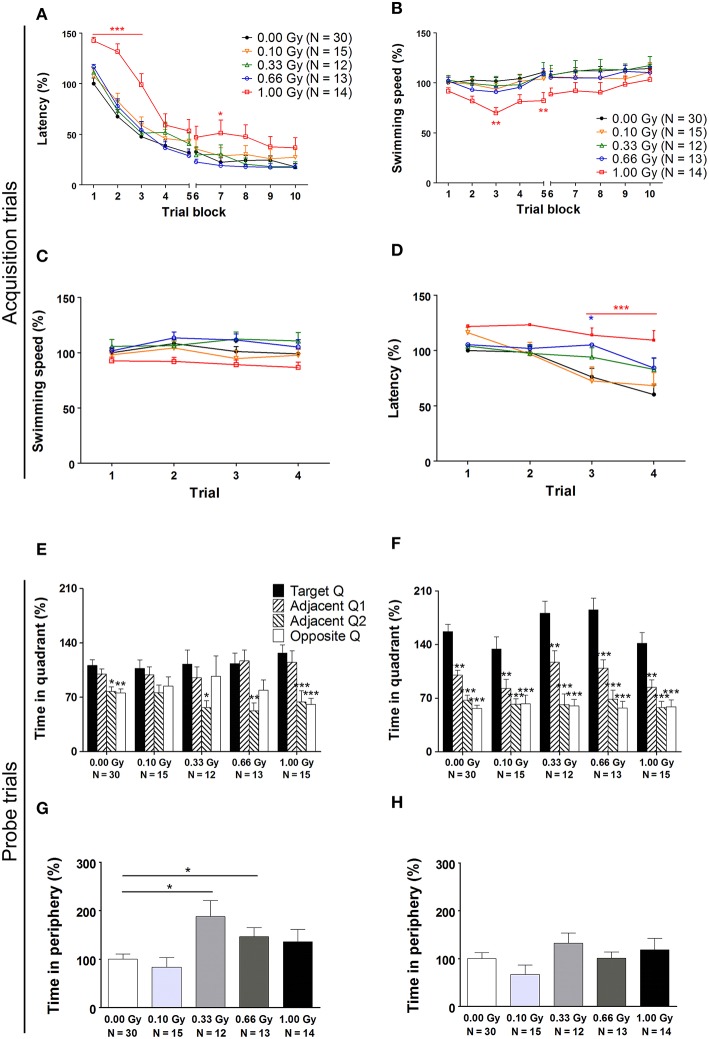
A traditional hidden-platform MWM analysis points toward aberrations in learning and memory in mice irradiated at E11. (A) A 10-day MWM protocol was exploited to evaluate changes in spatial learning and memory between control and in utero irradiated mice. This revealed an increased latency of 1.00-Gy exposed animals to find the hidden platform, which was especially apparent during the first trial days of the test. (B) During these trials, the high-dose exposed mice displayed a lower swimming speed. (C,D) More careful examination of the first trial day showed that significant changes in escape latency were already visible in 0.66- and 1.00-Gy irradiated animals (C), while the decreased swimming velocity in high-dose irradiated animals was not that evident yet (D). (E,F) The probe trials performed on day 6 (E) and 11 (F) did not indicate a pronounced effect of irradiation on quadrant preference. Asterisks indicate significant differences in time spent in the respective quadrants in respect to the target quadrant for each experimental group. (G,H) Notably, mice exposed to a moderate irradiation dose showed an elevated time in swimming in the periphery during the probe trial at day 6 (G), but this difference disappeared in the day 11 probe trial (H). Data are presented as mean ± SEM. *P < 0.05, **P < 0.01, ***P < 0.001. The number of animals used is indicated in the graphs (N). E, embryonic day; Gy, Gray; MWM, Morris water maze; Q, quadrant.